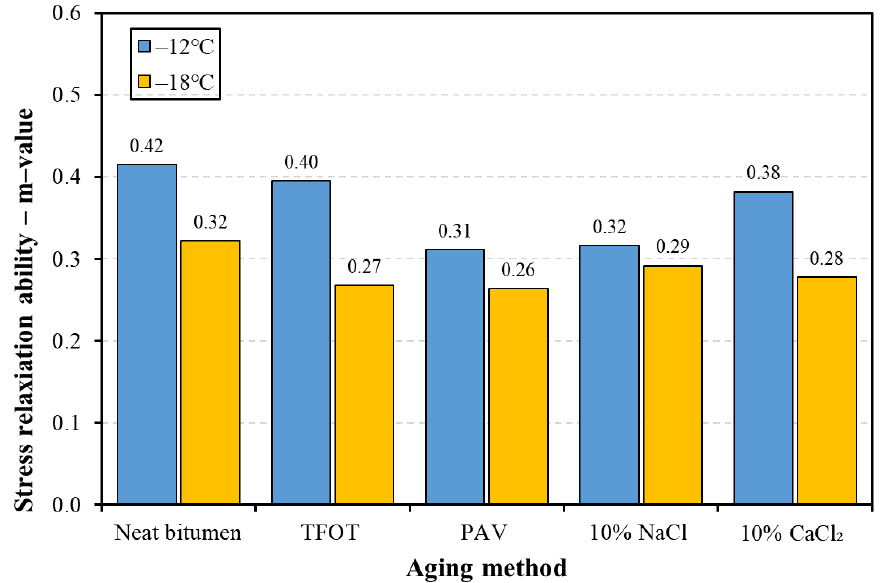
Figure 7. The stress relaxation ability of bitumen before and after aging. Table 5. The limited temperature of five kinds of